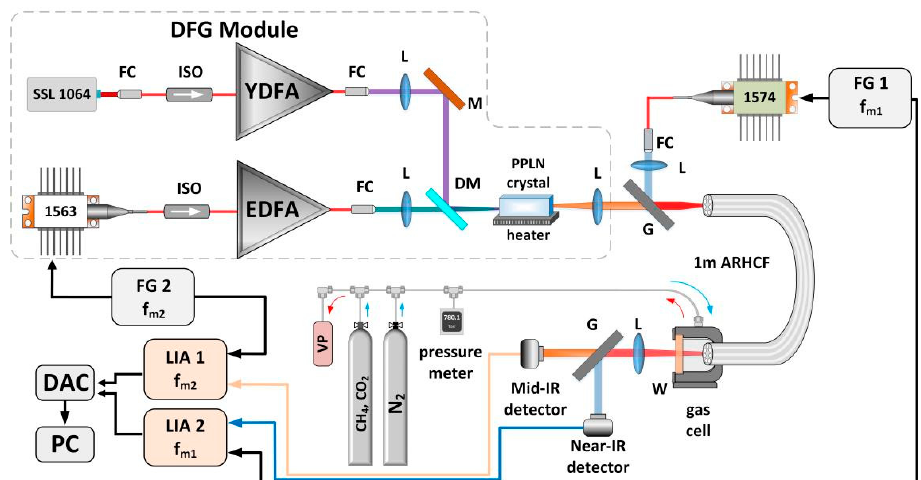
Figure 7. Schematic of the dual-gas sensor based on the near- and mid-IR guiding ARHCF and WMS technique. SSL—diode pumped solid state laser, FC—fiber collimator, ISO—isolator, YDFA/EDFA—Ytterbium- and Erbium-doped fiber amplifiers, L—lenses, M—mirror, DM—dichroic mirror, G—germanium window, W—CaF 2 wedge, FG—function generator, LIA—lock-in